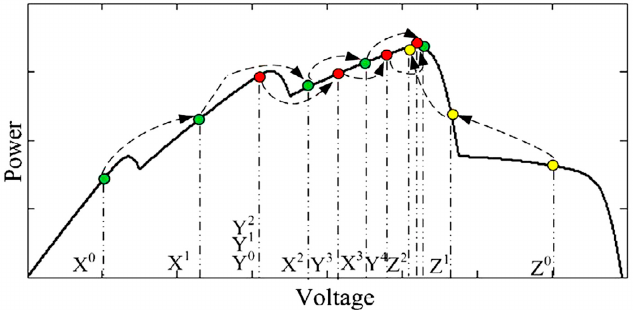
Figure 19. Cuckoo search under partial shading conditions [78].